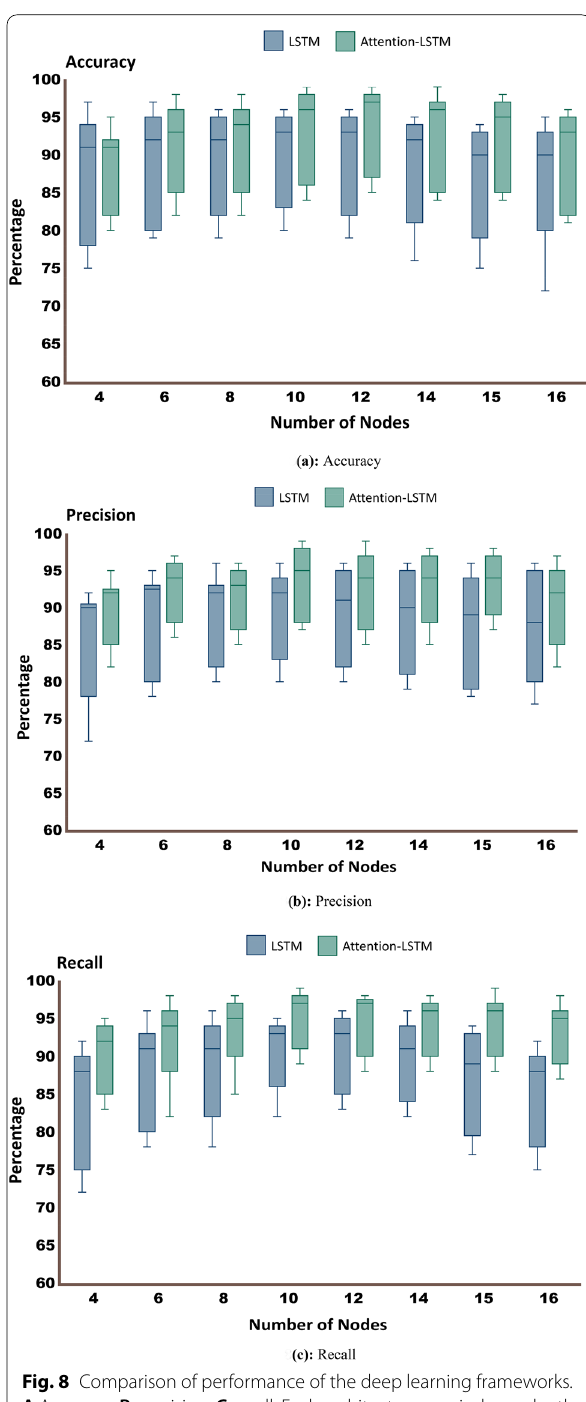
Fig. 8 Comparison of performance of the deep learning frameworks. A Accuracy, B precision, C recall. Each architecture was independently optimized with 4, 6, 8, 10, 12, 14, 15 and 16 LSTM input cells for temporal EEG sampling of 750, 500, 375, 300, 250, 214, 200 to 180 ms/ segment,